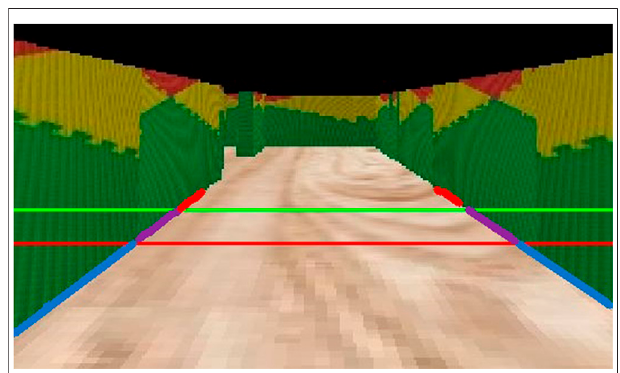
FIGURE1| Thethree areas obtained bytherobot, dividedbygreenand red